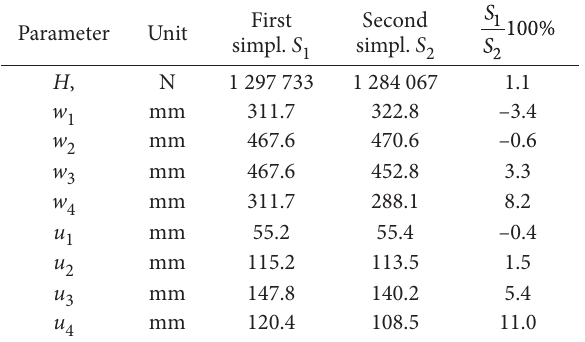
Table 1. Numerical results of the example Parameter Unit